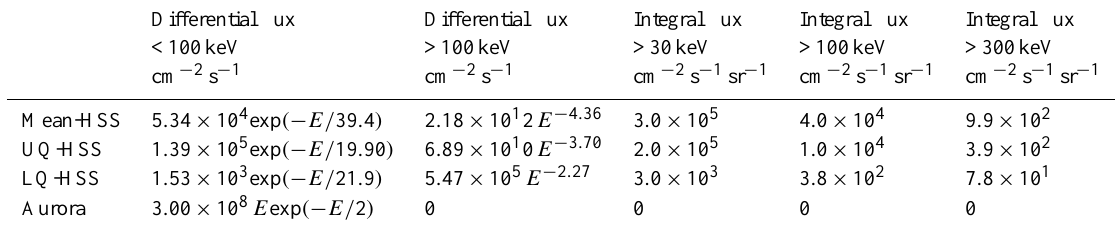
Table 1. Mean daily downward differential flux models used to calculate ionization rate profiles. Fluxes at energies E >30keV are power-law fits to precipitating fluxes during the first day following the arrival of high-speed solar wind streams according to Meredith et al. (2011). Fits to the lower quartile (HSS-LQ), mean (HSS-mean) and upper quartile (HSS-UQ) integral fluxes are shown (note that mean fluxes are higher than UQ). “Aurora” is a representative auroral spectrum (Kirkwood and Eliasson, 1990). Corresponding integral fluxes for E >30, 100 and 300keV are shown in the last three columns for comparison with Meredith et al.,